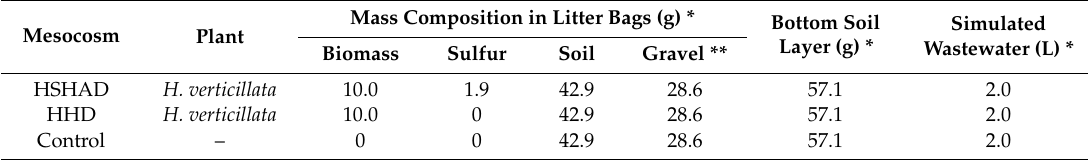
Table 1. Details of experimental